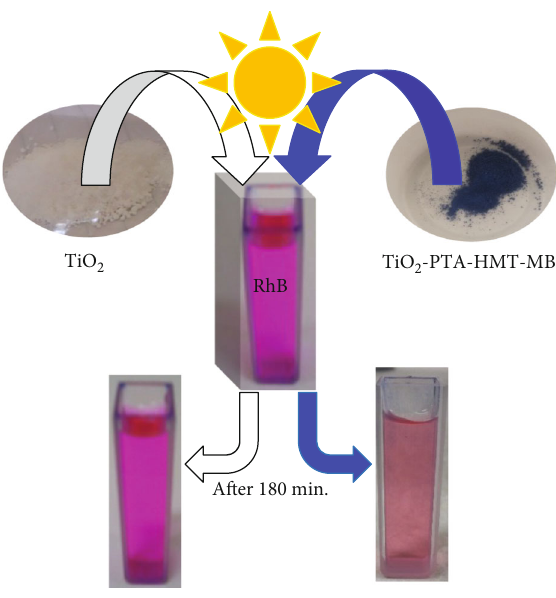
Scheme 1: Schematic illustration of the solar photocatalytic experiment for